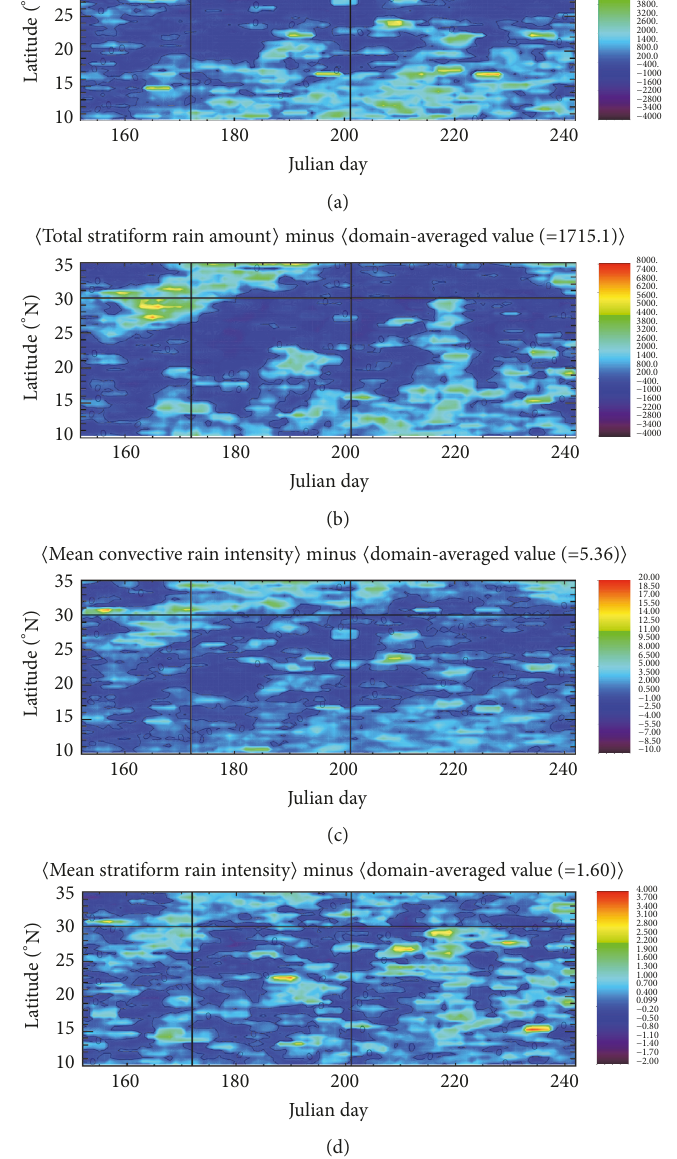
Figure 8: Climatological anomaly propagation of the total rain amount for (a) convective and (b) stratiform rain clouds and of mean rain intensity for (c) convective and (d) stratiform rain clouds in the 2-dimensional space with time (Julian day) and latitude. The two vertical lines represent the beginning and end dates of the climatological period for